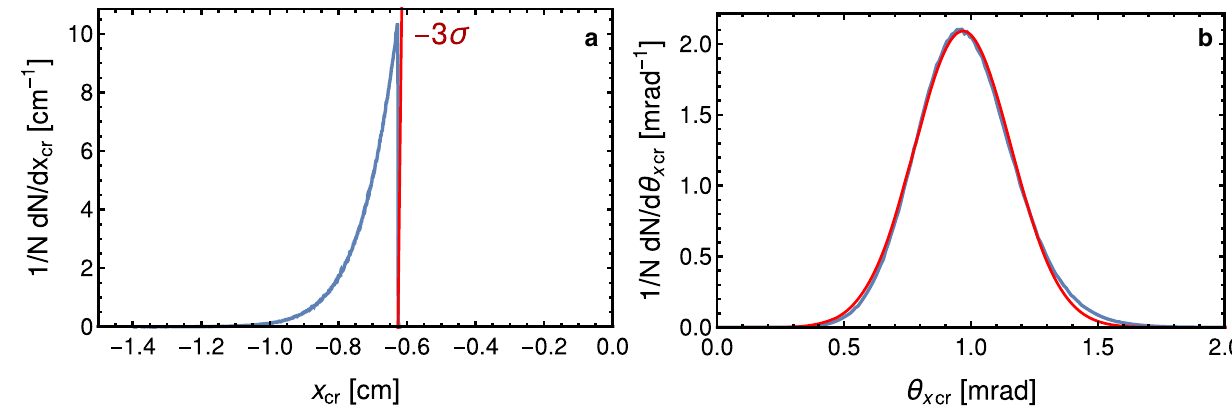
Fig. 5 Transverse a spatial coordinate and b angular distributions of the beam at the position of the deflection device (bent crystal). The crystal boundary is placed at x = − 3 σ . The red curve in b indicates the result of a Gaussian fit